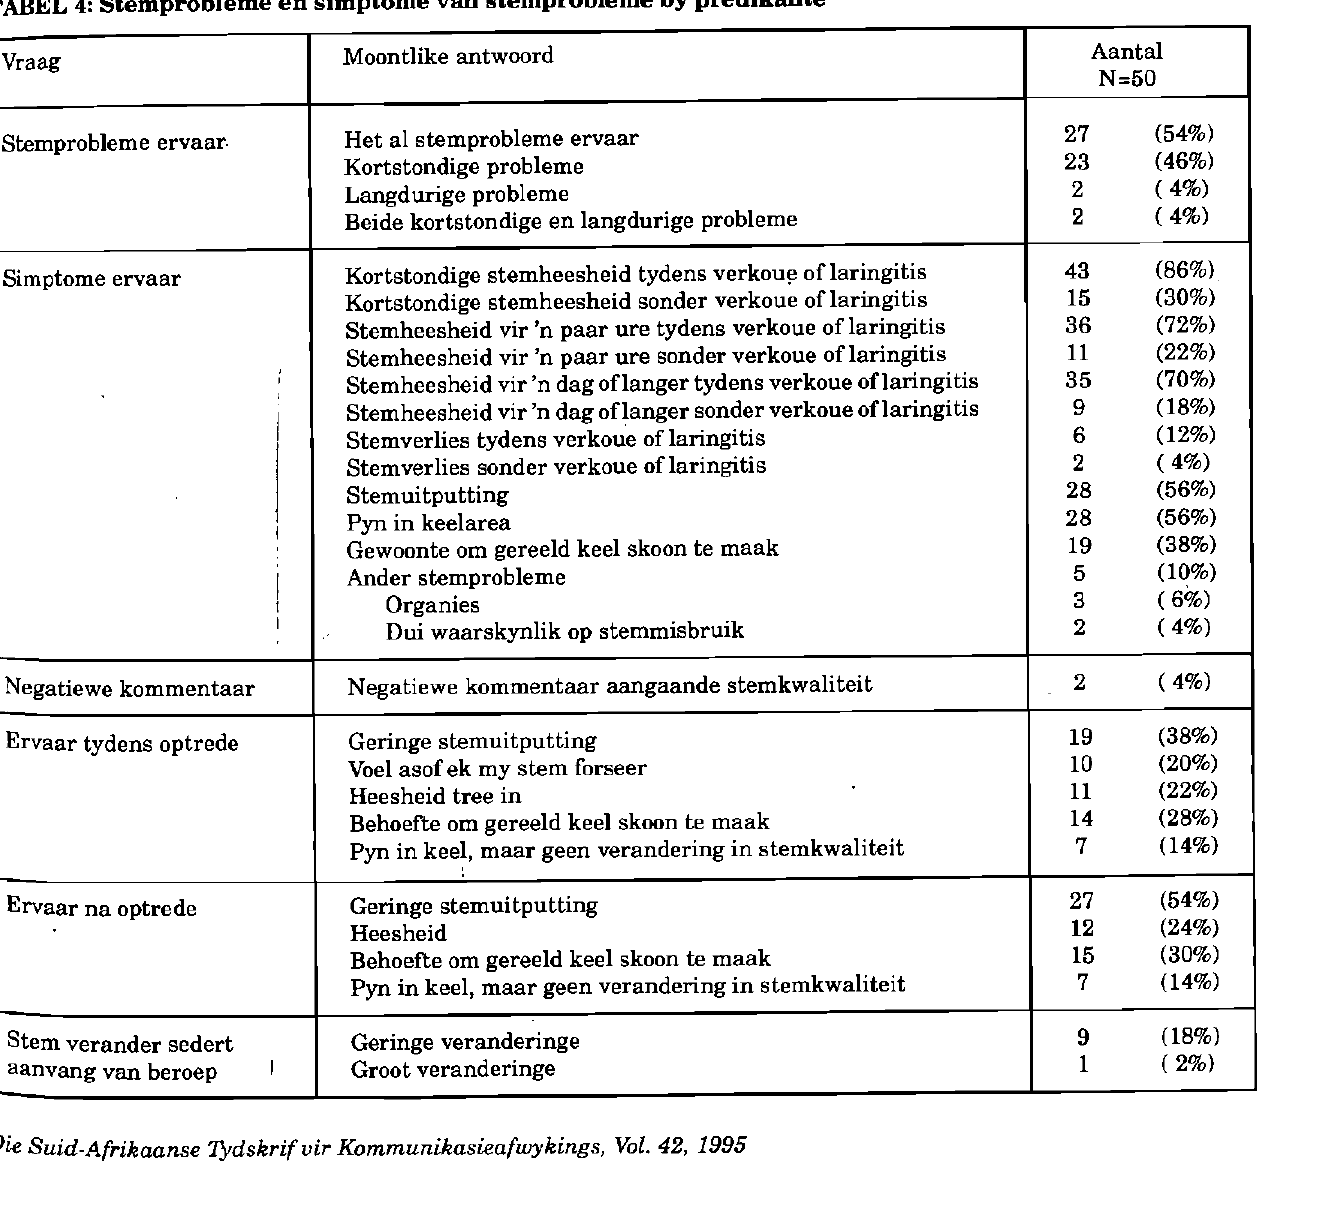
TABEL 4: Stemprobleme en simptome van stemprobleme by predikante Vraag Moontlike antwoord